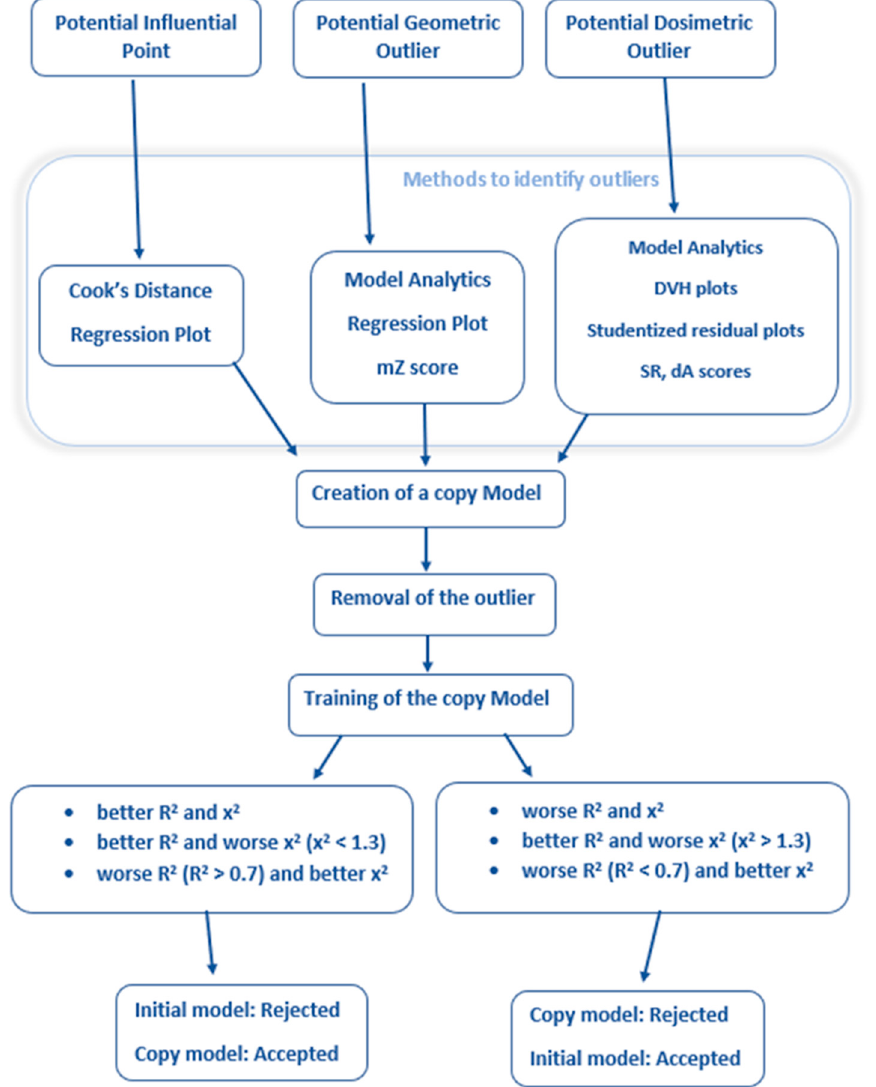
Figure 2. Workflow followed for investigation of